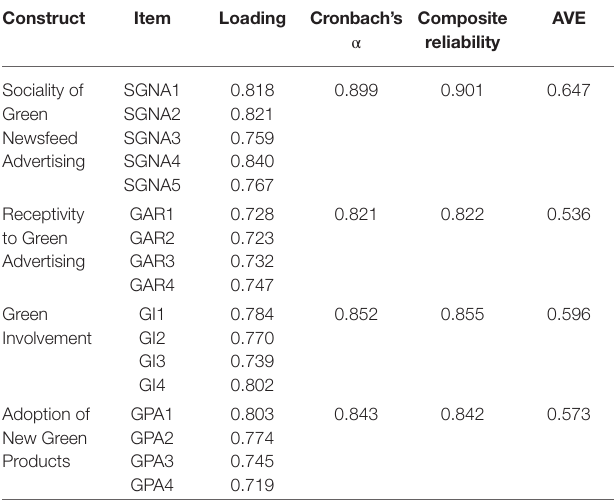
TABLE 2 | Confirmatory factor analysis (CFA) results for the measurement model.